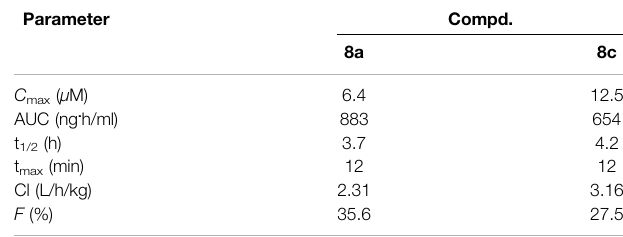
TABLE 4 | Pharmacokinetic properties of hybrids 8a,c in mice. Parameter